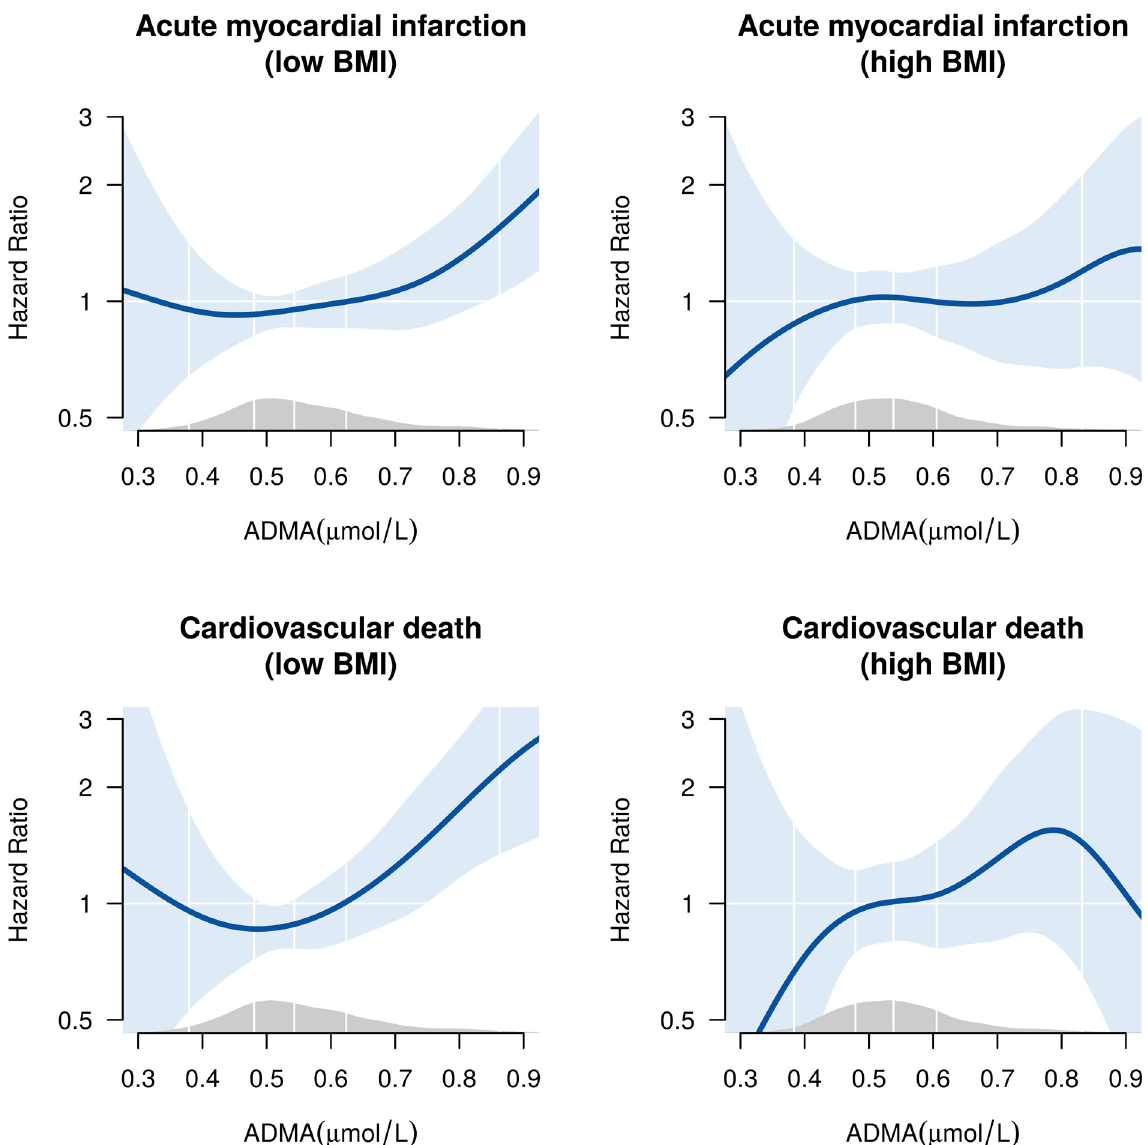
Fig 1. Plasma asymmetric dimethylarginine and risk of acute myocardial infarction and cardiovascular death in patients with low vs. high BMI. Association between plasma asymmetric dimethylarginine (ADMA) levels ( μ mol/L) and acute myocardial infarction (upper panels) and cardiovascular death (lower panels) in patients with body mass index (BMI) equal to or below median BMI (26.3 kg/m 2 ) (low BMI) and BMI above median (high BMI). The nonlinear smoothing splines estimate of the hazard ratio were estimated with additive Cox proportional hazard regression models and adjusted for age (years), sex, diabetes mellitus (yes/no), current smoking (yes/no), statin treatment (yes/no), homocysteine ( μ mol/L), hemoglobin (g/dL) and apoB/apoA-I ratio and Lp(a) (mmol/L). The density plot along the X-axis shows the distribution of plasma ADMA.